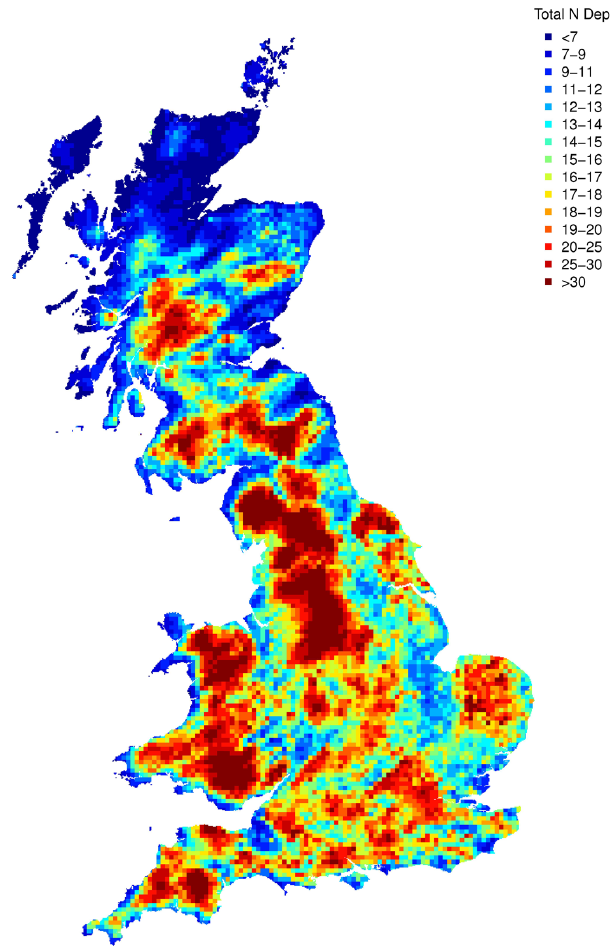
Fig. 1. Total inorganic N deposition (kgNha − 1 yr − 1 ) to heathland and rough grazing land in Great Britain. CBED deposition data for